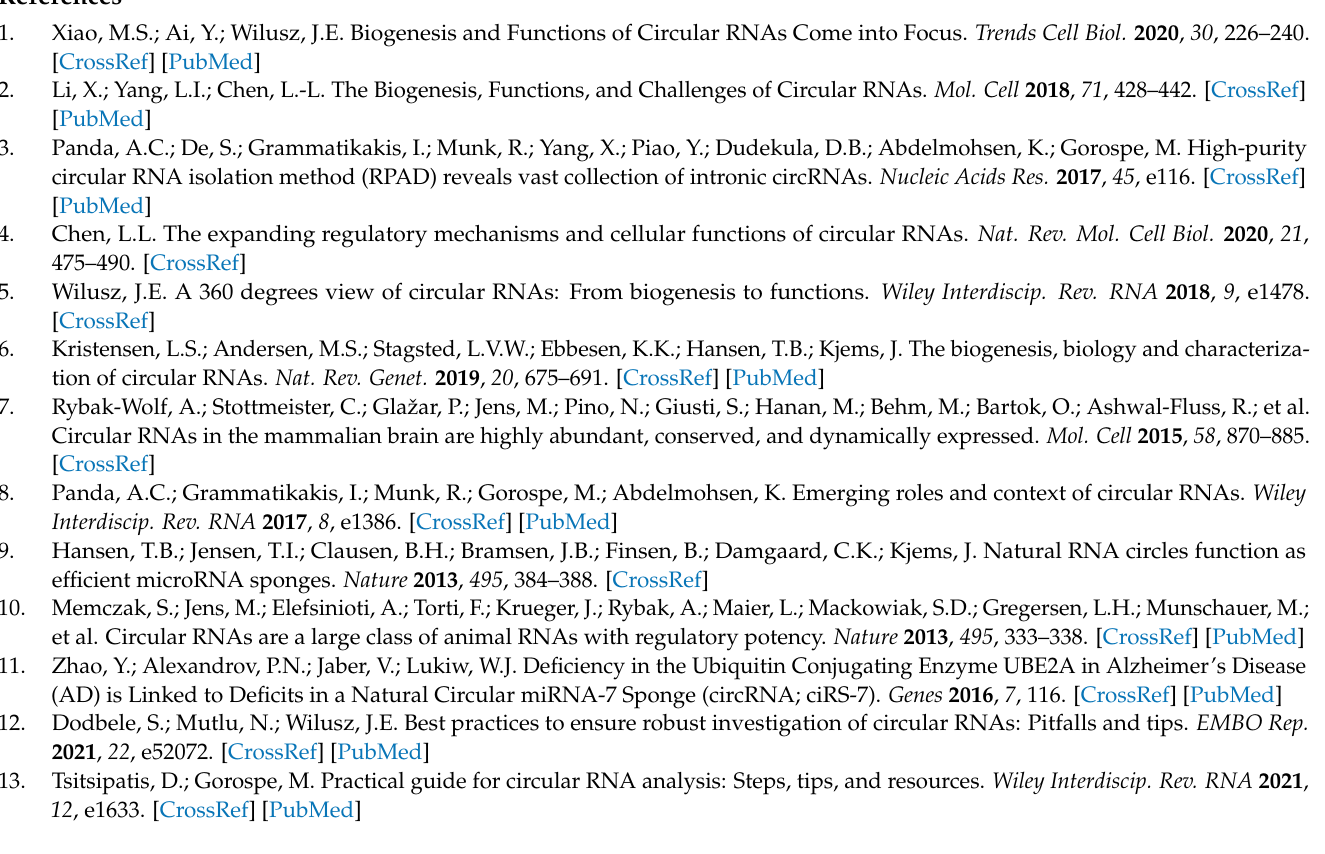
Figure 3, Table S2: CircRNAs from figure 5A. Table S3: CircRNAs from Figure